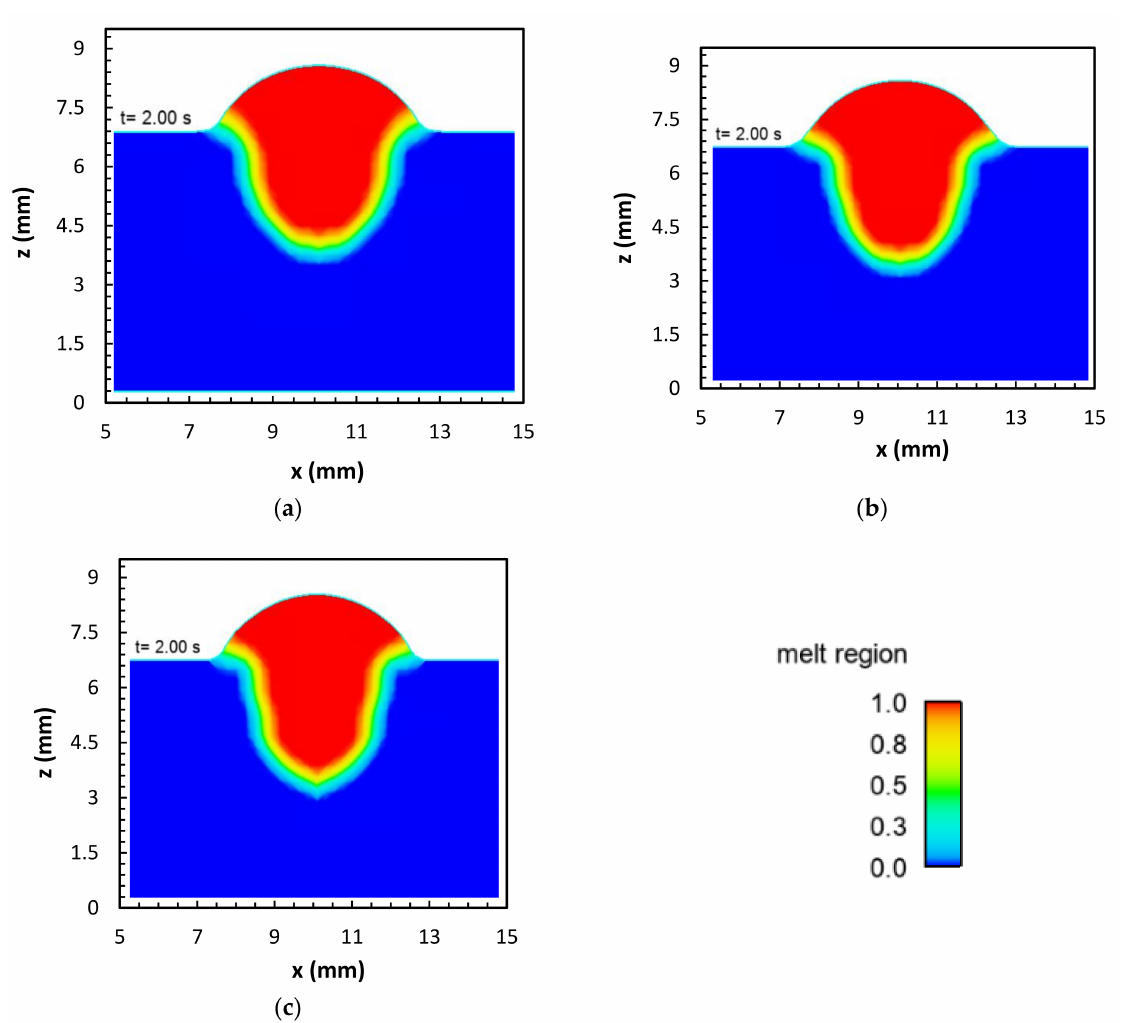
Figure 11. Melt region of the weld pool at 2 s for oxygen concentration, ( a ) 310 ppm, ( b ) 420 ppm, and ( c ) 500